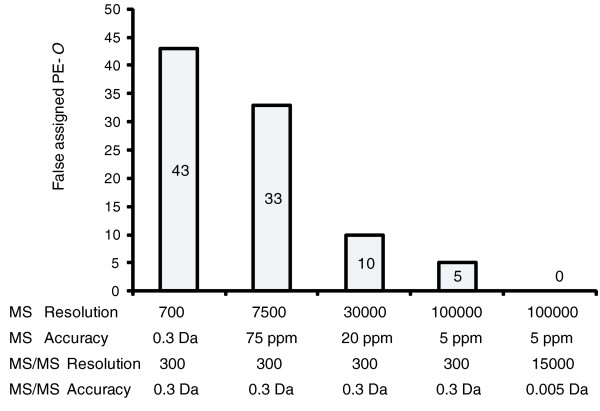
LipidXplorer accurately interprets both high and low resolution mass spectra. The number of PE-O species falsely assigned by LipidXplorer software in shotgun analysis of a total E. coli lipid extract under different target mass resolutions.